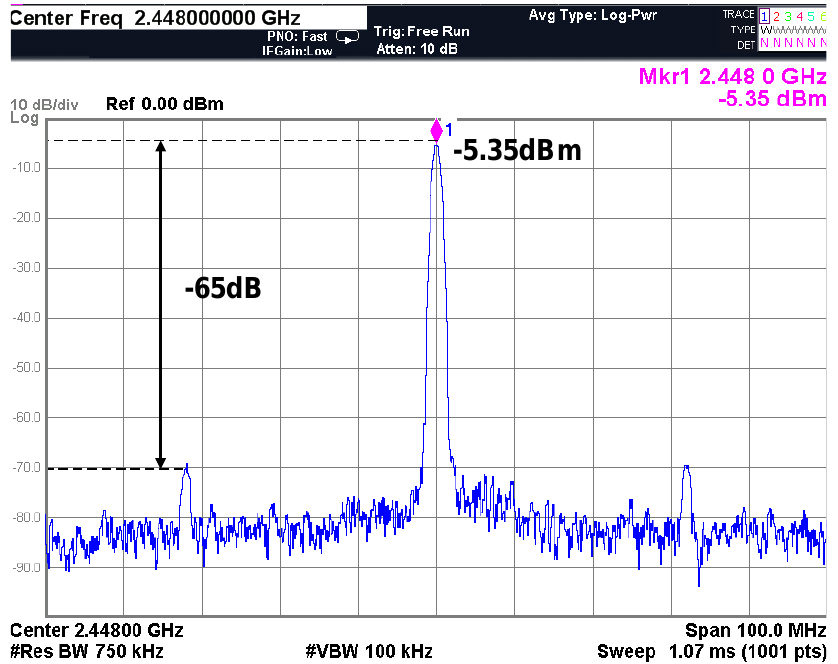
Figure 20. Measured ADPLL spurious